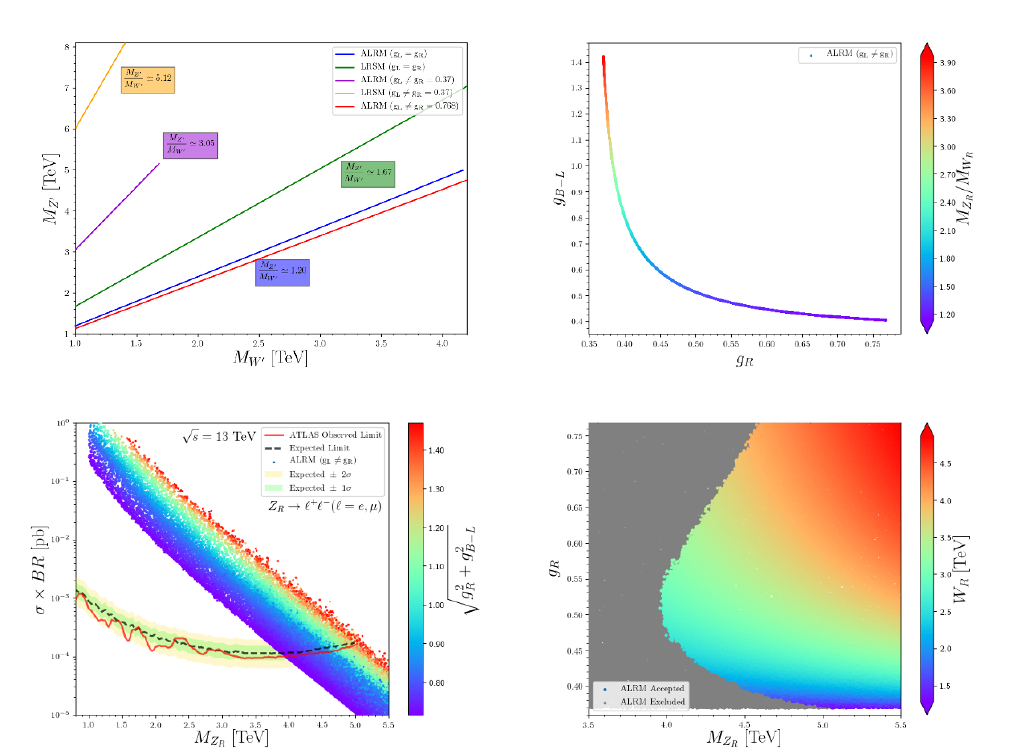
Figure 1 . Properties of the gauge sector for the ALRSM scenarios featuring a Higgs sector com- patible with data. We emphasise the relations between the W 0 and Z 0 boson masses with the gauge couplings and also investigate the LHC constraints on the mass of the Z 0